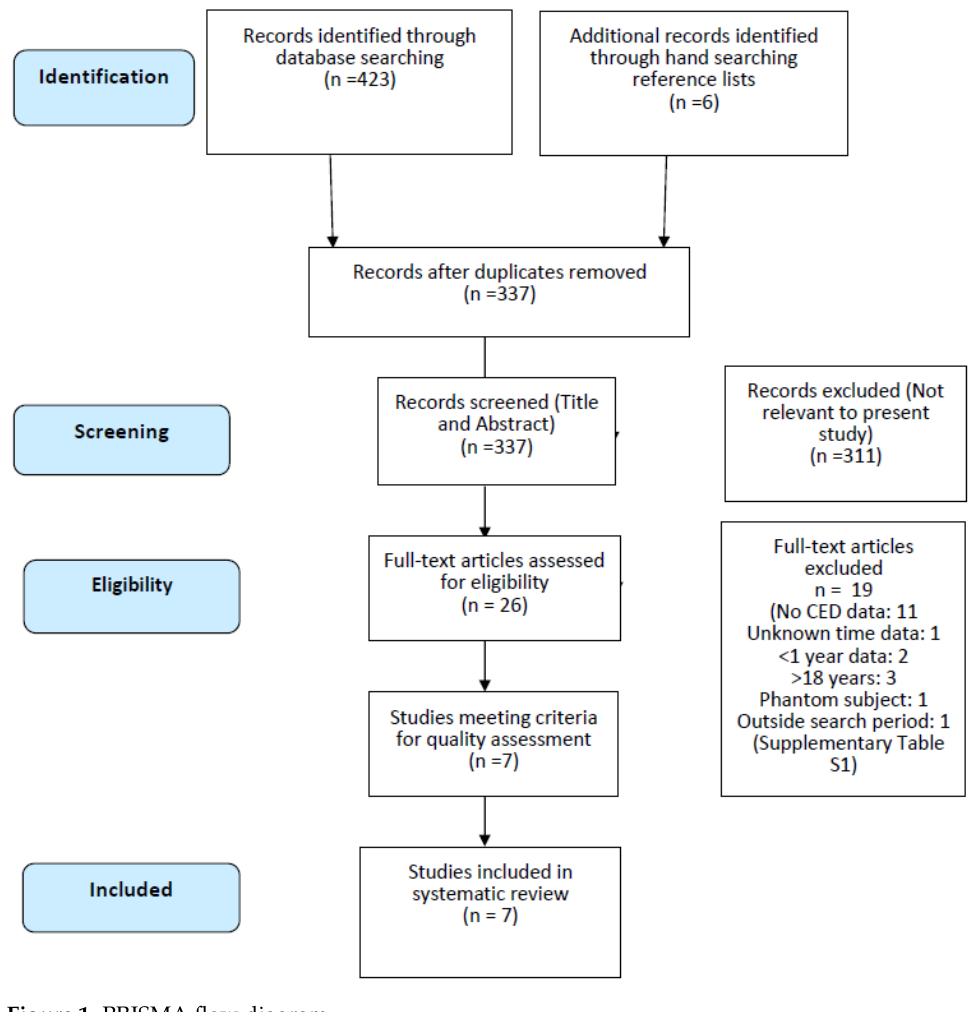
Figure 1. PRISMA flow